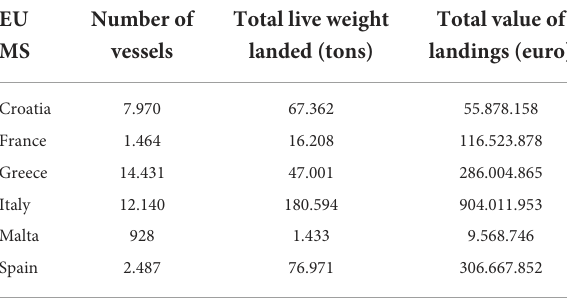
TABLE 6 Average number of active vessels, volume and value of the landings by MSs for 2017–2019.